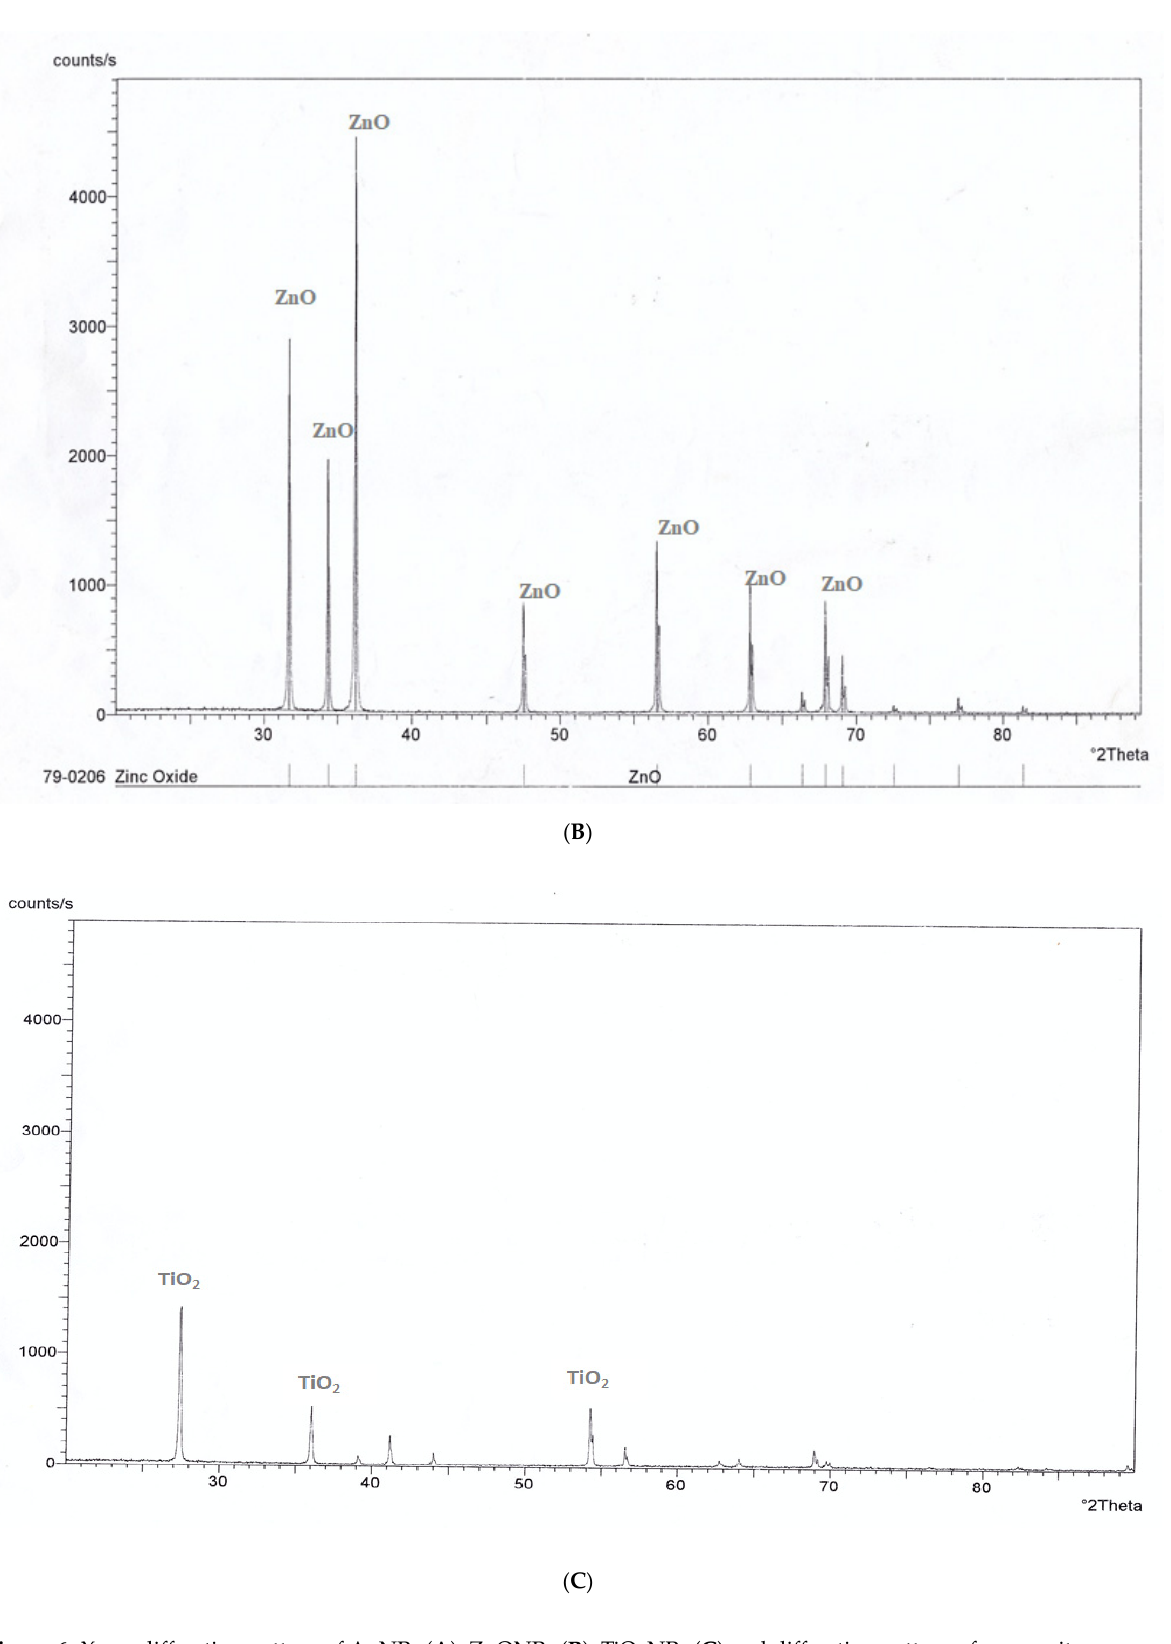
Figure 6. X-ray diffraction pattern of AgNPs ( A ), ZnONPs ( B ), TiO 2 NPs ( C ) and diffraction pattern of composite nanoparti- cles ( D ) composite 500 µ L AgNPs–500 µ L ZnO nanoparticles, composite 750 µ L AgNPs–250 µ L ZnO nanoparticles and composite 750 µ L TiO 2 nanoparticles–250 µ L ZnO